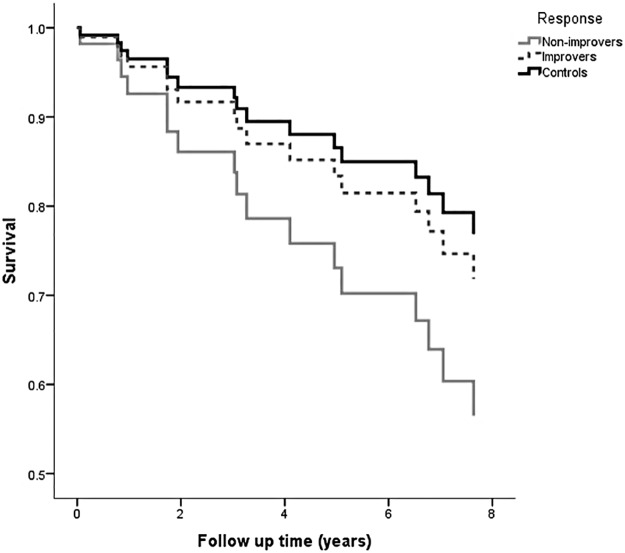
Survival curves for revascularized patients divided into improvers versus non-improvers, and comparing with non ARVD control patients, adjusted for baseline age, co-morbidities, and GFR.